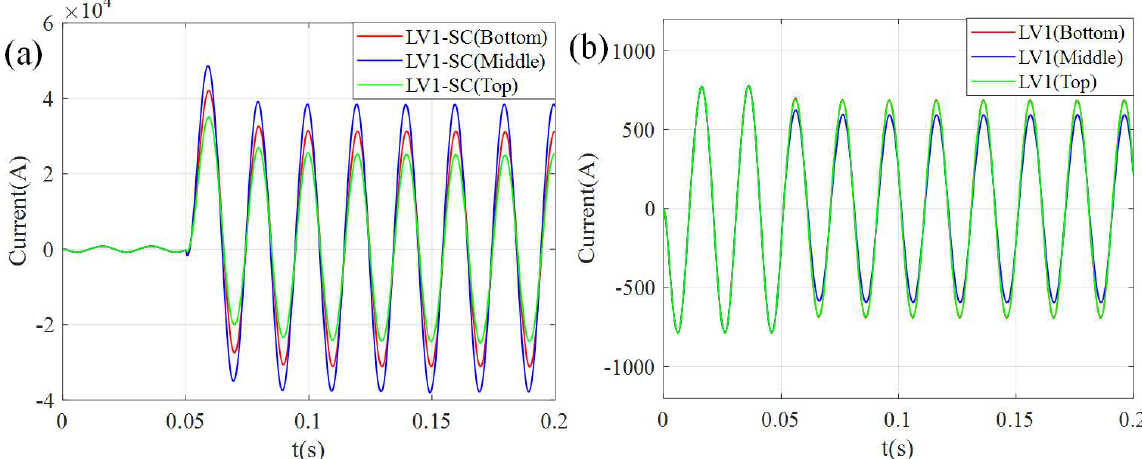
Figure 6. The currents of LV1 sort-circuit winding and LV1 winding under three cases of TTFs. ( a ) The current of LV1 sort-circuit winding (LV1-SC). ( b ) The current of LV1